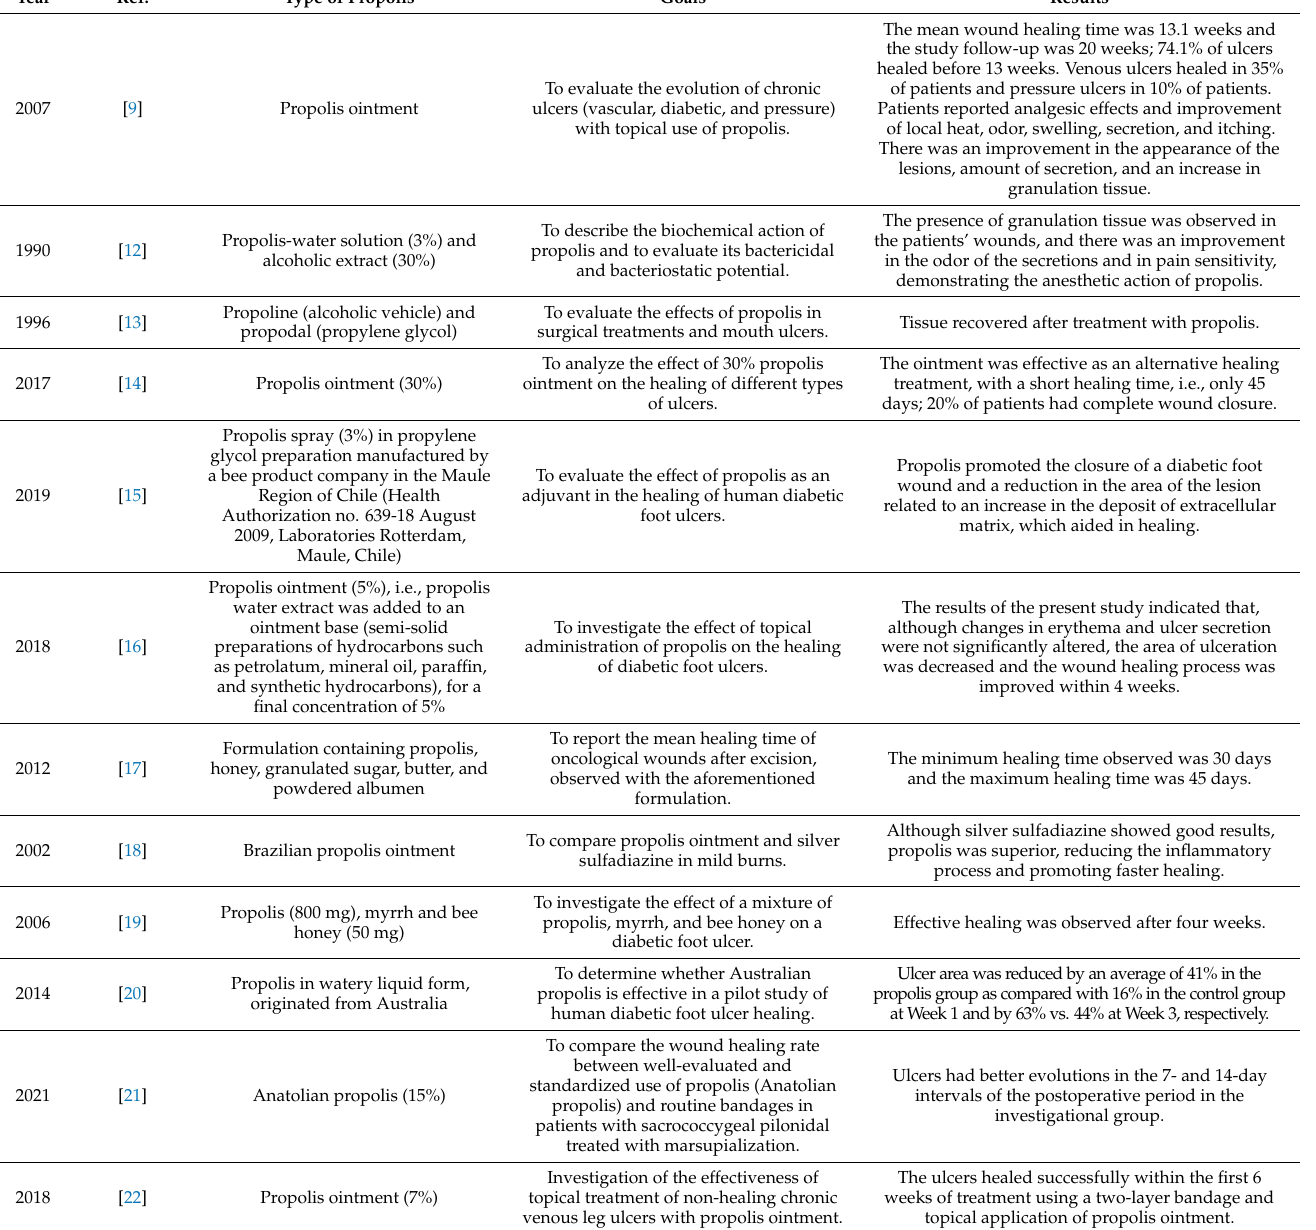
Table 1. Summary of results about the healing potential of propolis in skin wounds, which has been obtained through clinical studies conducted between 1990 and